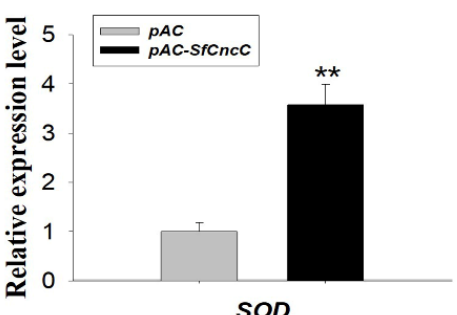
Figure 4. Over-expression analyses of Sf CncC regulate SOD gene transcription in Sf9 cells. The mRNA transcription level (means ± SD) of SOD in Sf9 cells transfected with pAC- Sf CncC construct and pAC vector. The error bars indicate 95% confidence intervals (n = 3). ** indicated significant difference by Student’s t-text ( p < 0.01).